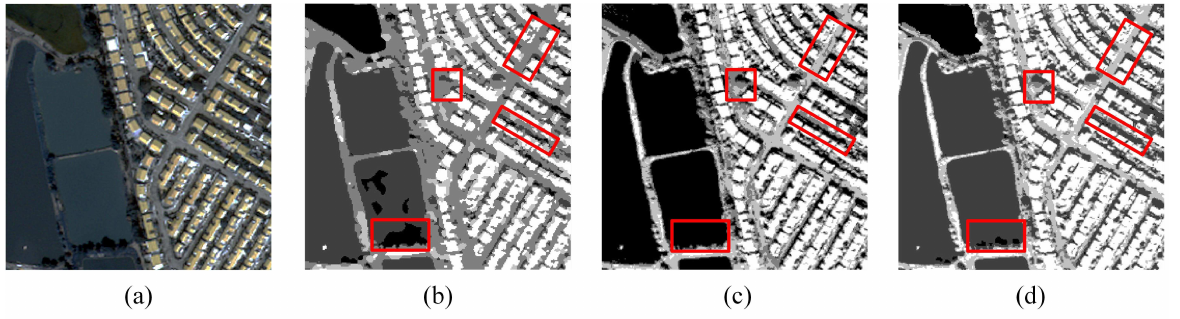
Figure 5. Comparison of semantic segmentation results before post-processing. (a) False color composite image. (b) Results of PMRF. (c) Results of OMRF. (d) Results of OMRF-HA.